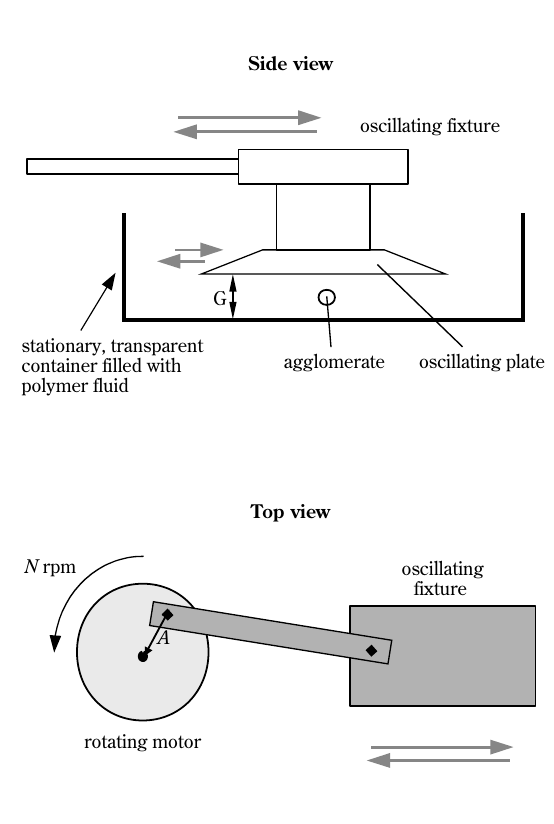
Schematic of the oscillatory shear device used for the unsteady shear experiments. G (cid:4) 4.83 mm and A (cid:4) 10